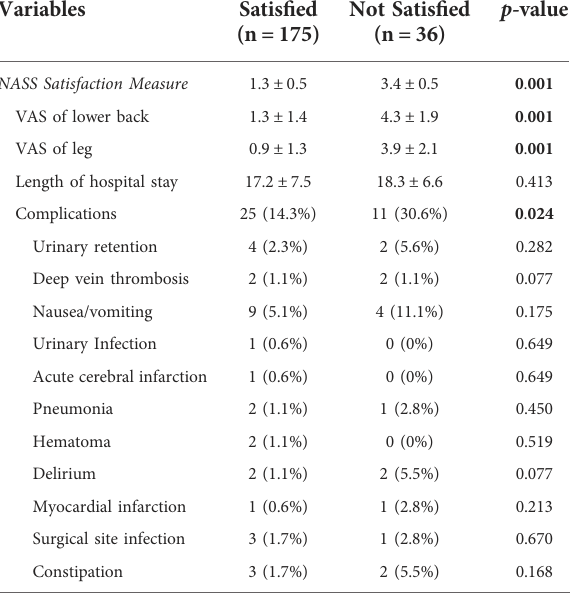
TABLE 4 Postoperative outcomes of patients in both groups.